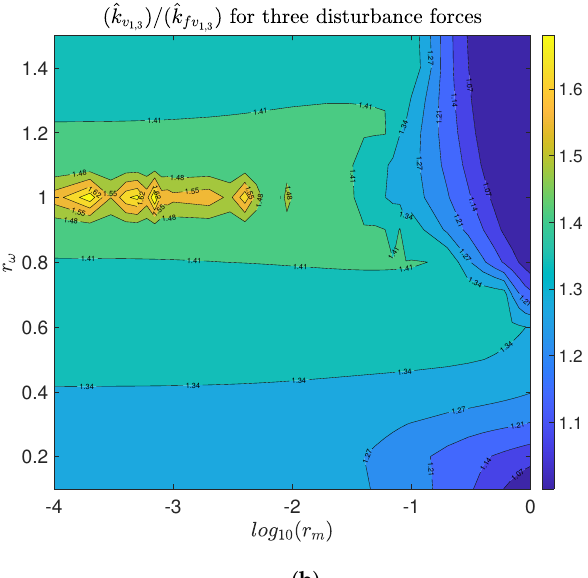
/ˆ k Figure 6. Ratio ˆ k v fv 1,3 for: ( a ) a single disturbance force; and ( b ) three disturbance forces for the 1,3 symmetrical